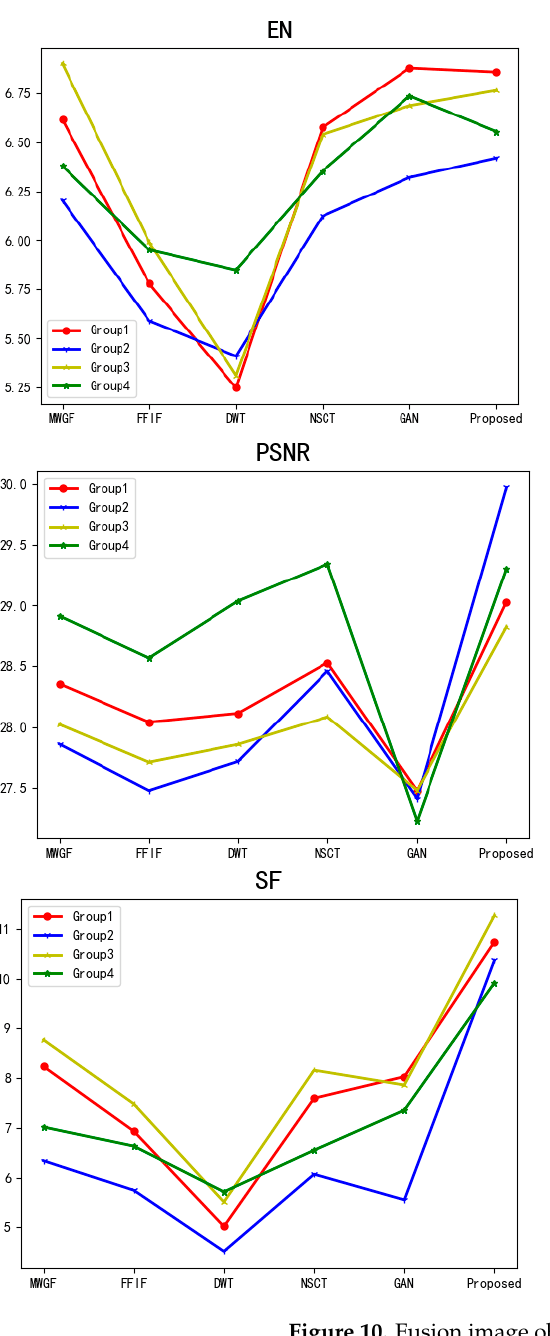
Figure 10 . Fusion image objective evaluation results. Figure 10. Fusion image objective evaluation